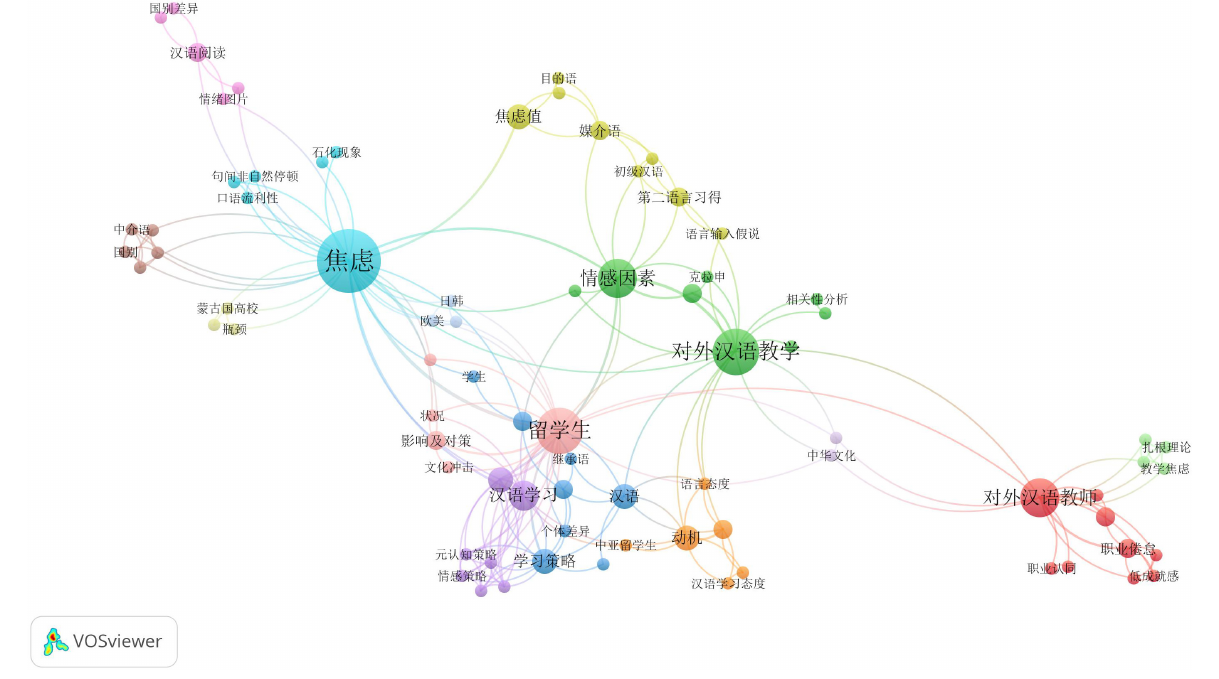
FIGURE 3 | Keywords co-occurrence in Chinese language